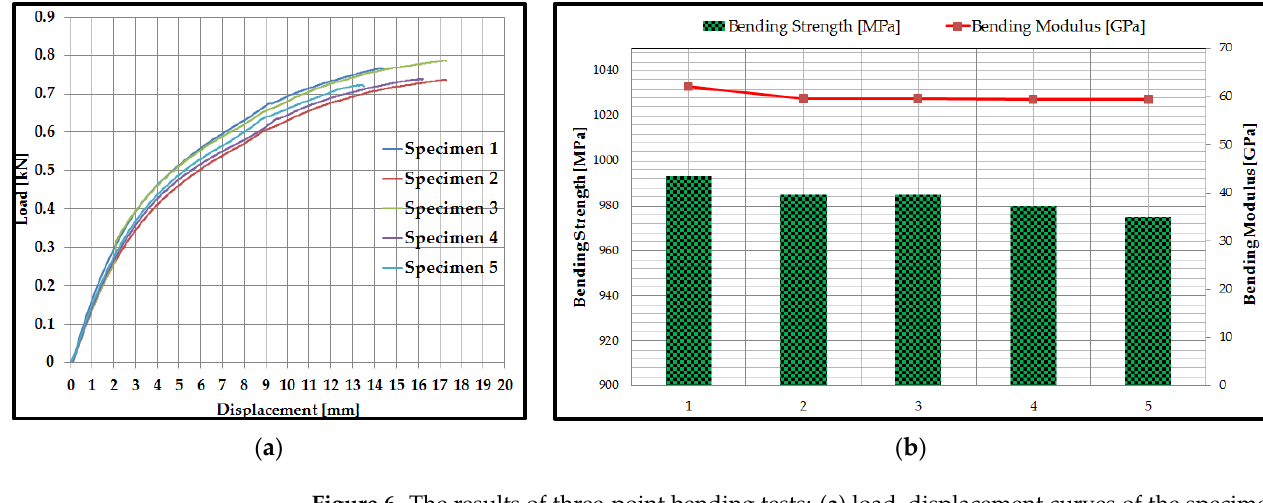
Figure 6. The results of three-point bending tests: ( a ) load–displacement curves of the specimens; ( b ) bending strength and bending modulus of specimens.